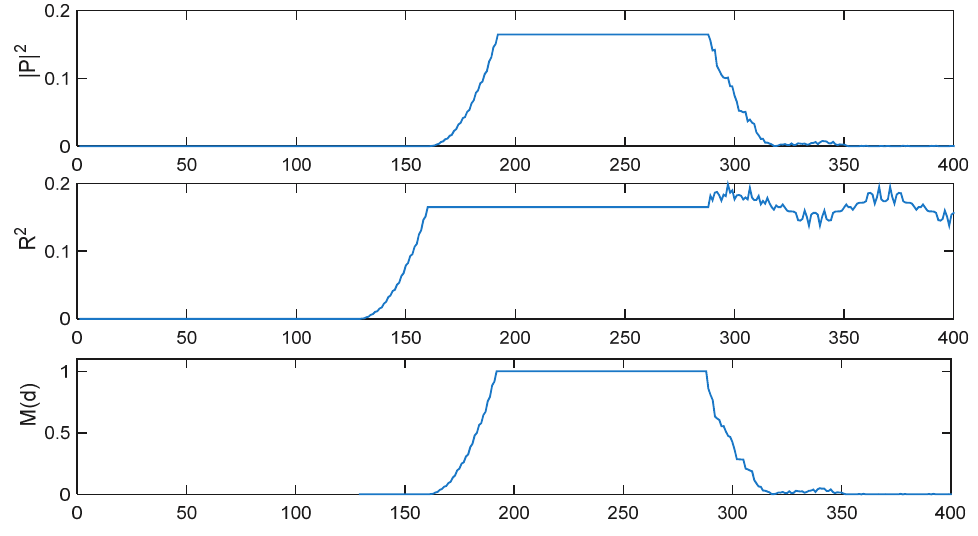
Figure 2. | P ( d )| 2 , R 2 ( d ) and M ( d ) of SC method with L = 32 in ideal